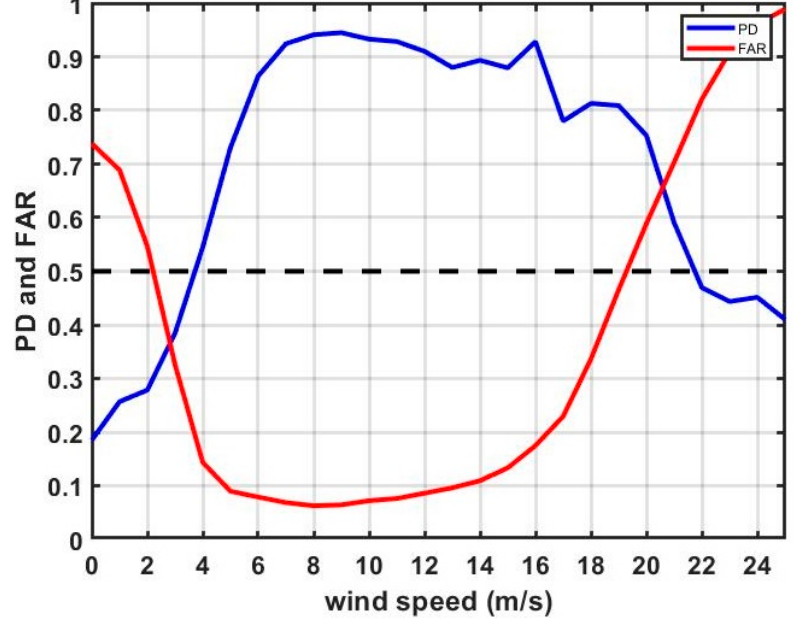
Figure 7. PD and FAR metrics for the CYGNSS test dataset.